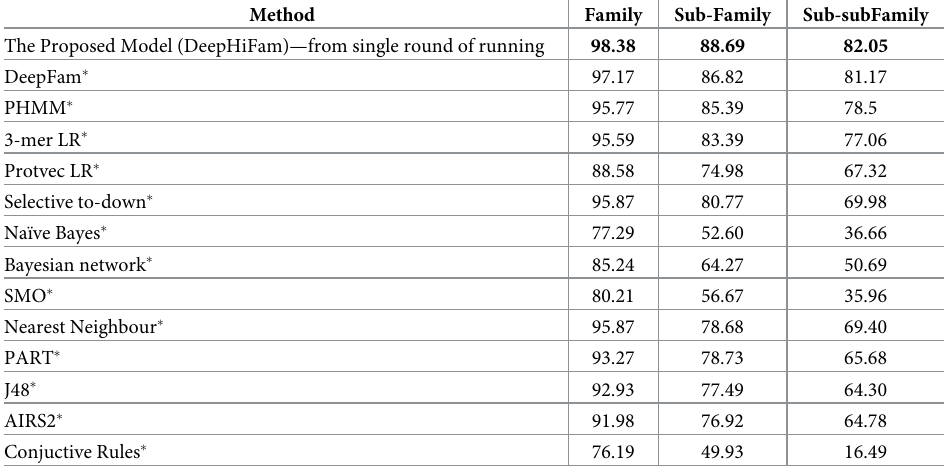
� Bold values are the highest./ � -Results from DeepFam